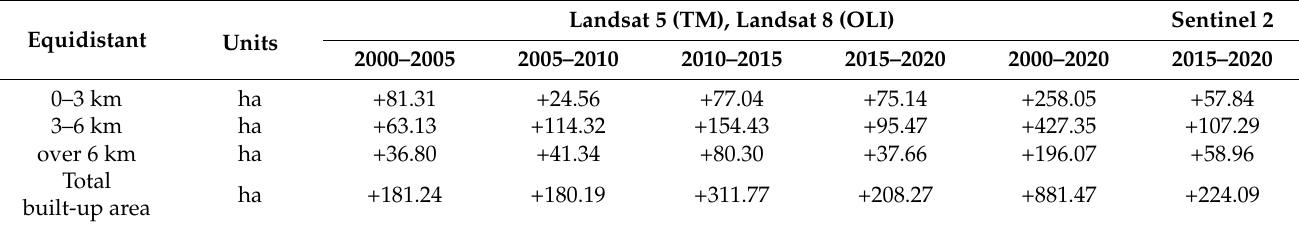
Table 5. Changes in built-up areas according to buffer zones from the centre of Opole obtained from processing of Landsat satellite images (2000, 2005, 2010, 2015, and 2020) and Sentinel (2015, 2020). Equidistant Units